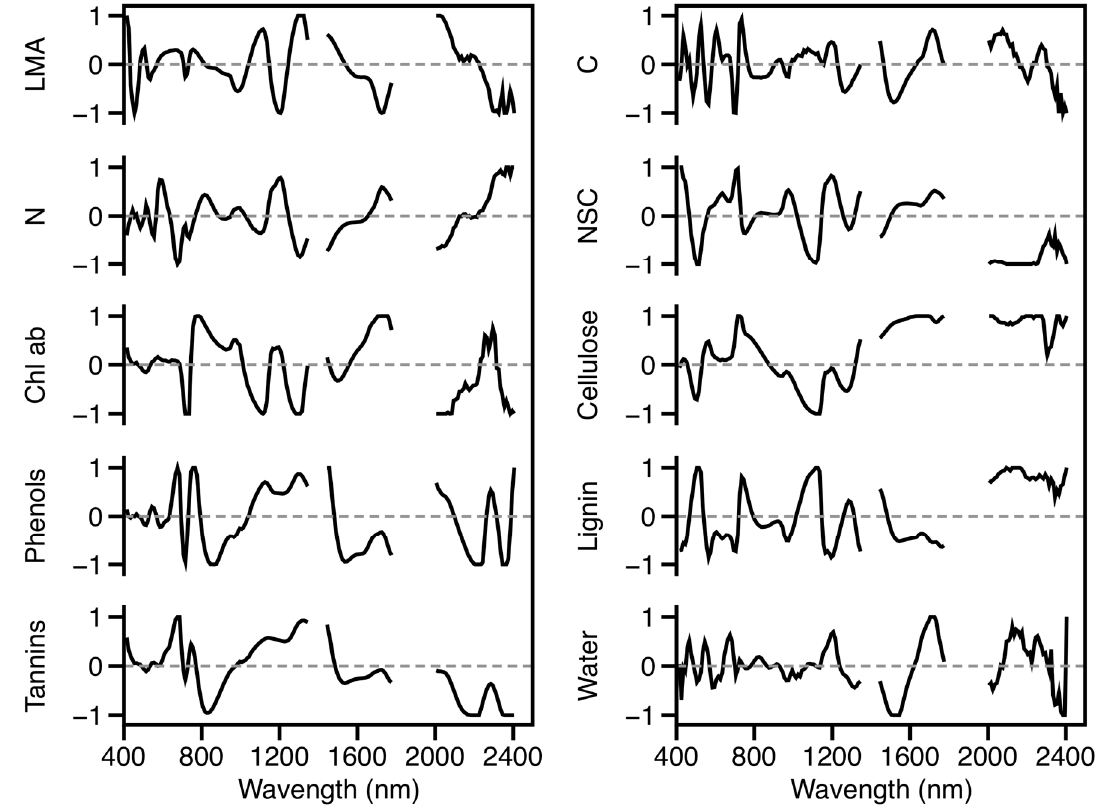
Figure 4. Partial least squares regression (PLSR) weightings determining chemometric relationships between leaf reflectance and leaf traits. Weighting values that depart from the zero line in each panel indicate where in the spectrum each leaf trait is quantitatively expressed.